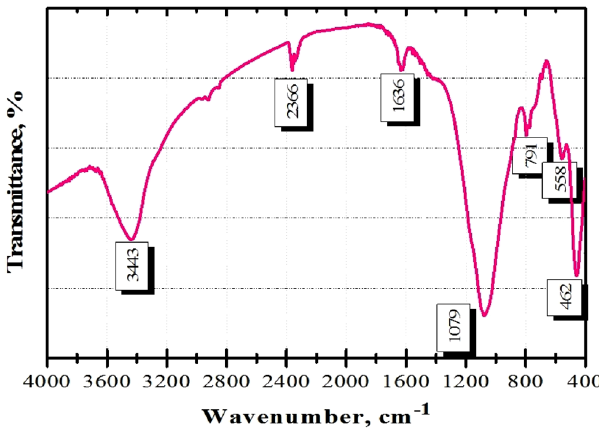
Figure 4. FTIR spectrum of fly ash.